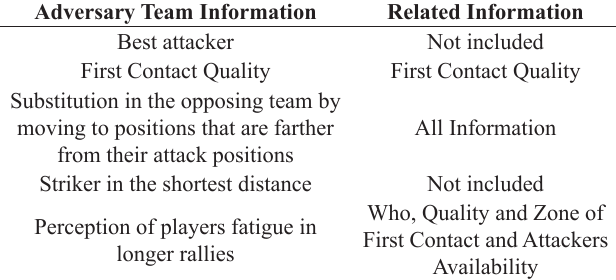
Table 6: List of information related to the setter’s own team comple- mented by the coaches with the information included in the question- naire during the Counter-Attack Processes.